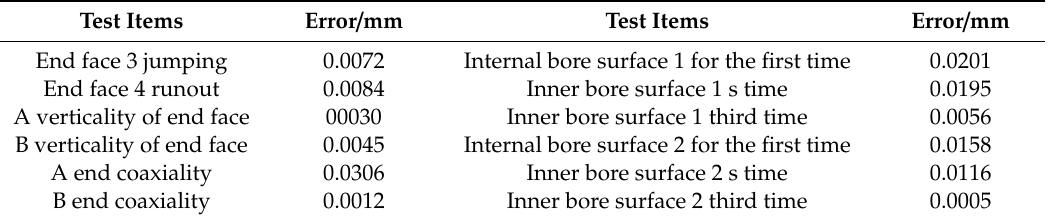
Figure 10. Plane test data diagram of workpiece ( A ) and ( B ). Table 2. Detection accuracy error table.